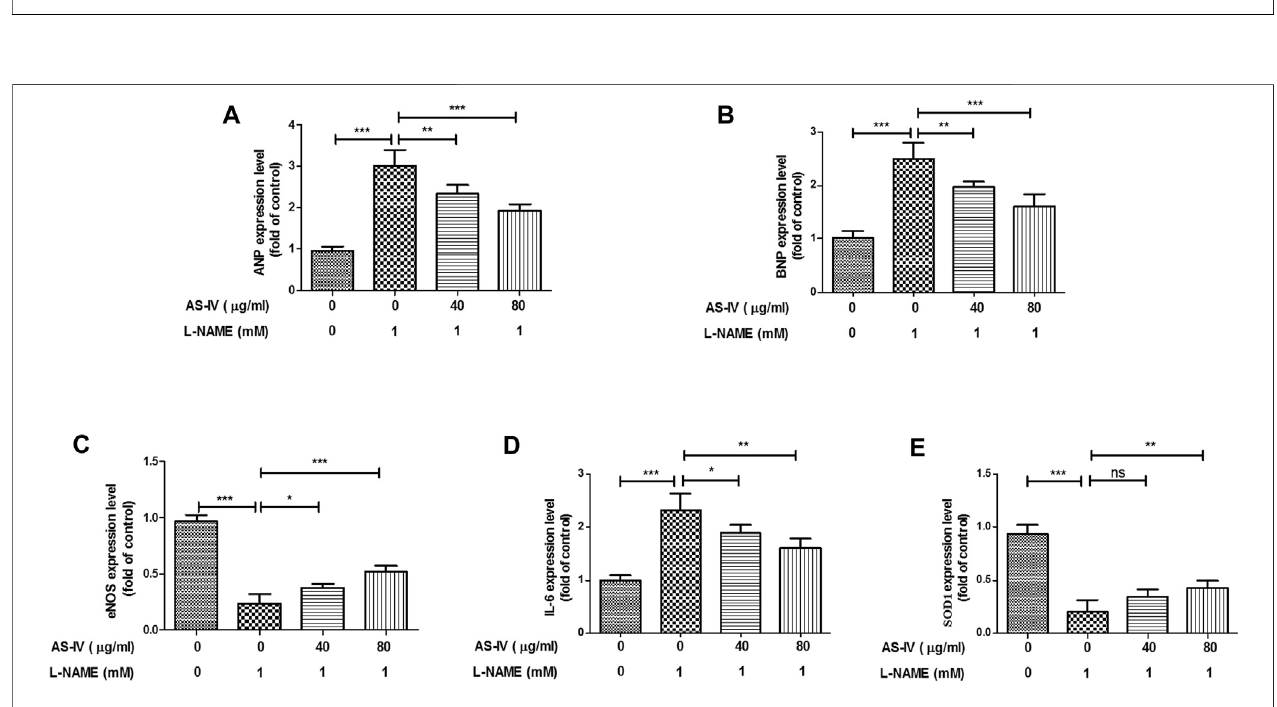
FIGURE11| TheprotectioneffectofAstragalosideIV(AS-IV)againstL-NAME-inducedin fl ammationandoxidativestressinH9C2cells.H9C2cellswerestimulated with different concentrations of AS-IV (40 and 80 μ g/ml) in the absence or presence of L-NAME (1 mM) for 24 h mRNA expression of ANP (A) , ABP (B) , eNOS (C) , IL-6 (D) , and SOD1 (E) were measured by qRT-PCR. Results were presented as mean ± standard deviation (SD). n (cid:1) 4. * p < 0.05, ** p < 0.01, *** p < 0.001.